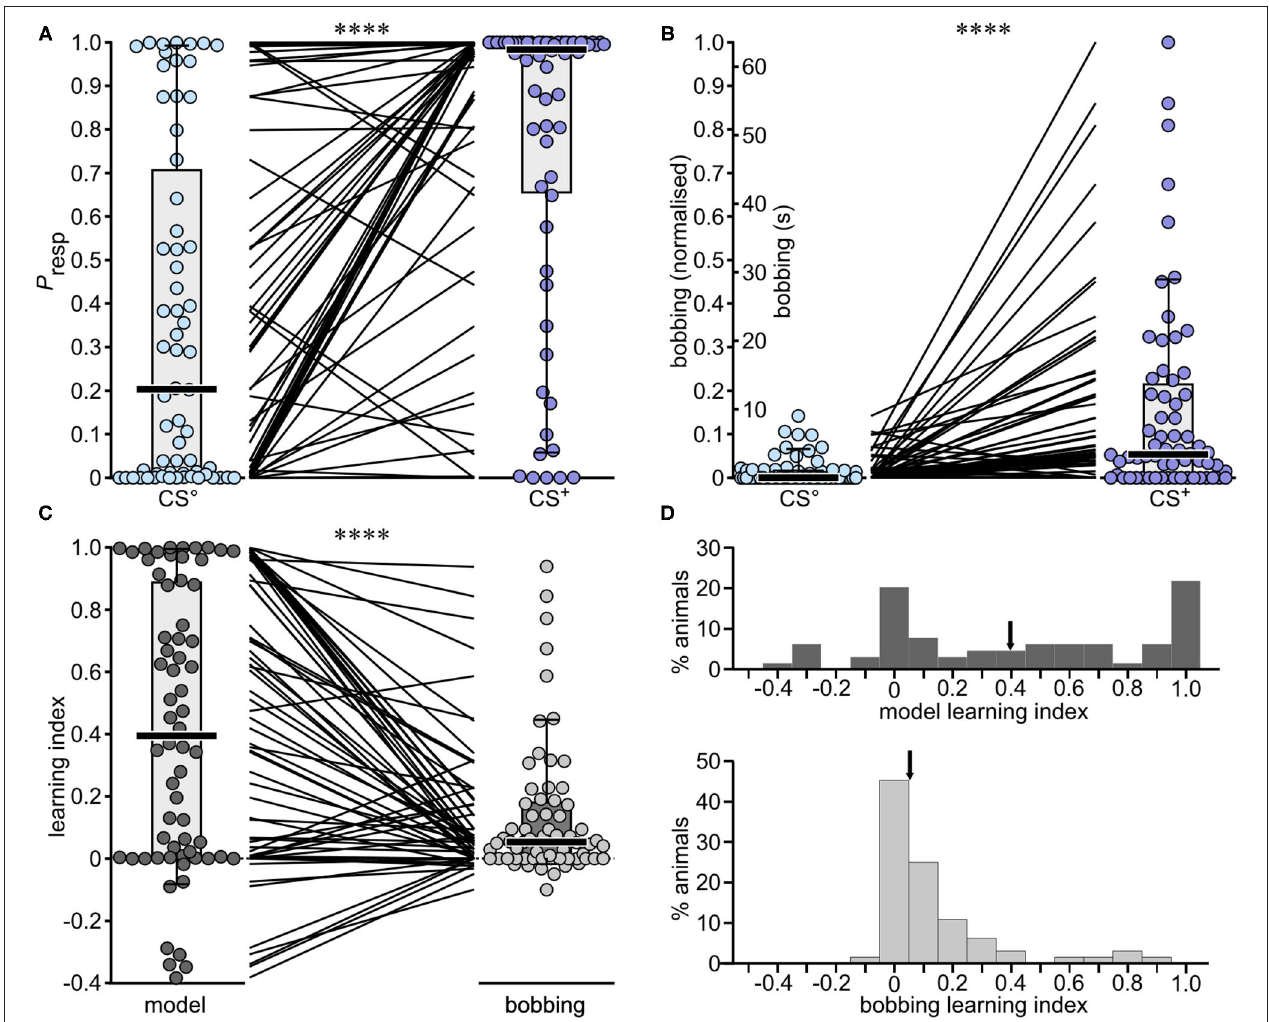
FIGURE 4 | Performances of individual crickets in the differential olfactory conditioning paradigm: A comparison of the binary regression Model-1 with bobbing . (A) Boxplots giving P resp values derived from the binary regression model for the non-rewarded and rewarded odour (CS ◦ and blue circles, respectively CS + and purple circles; bars: median; boxes: interquartile range; whiskers: 10th and 90th percentiles, N = 64). The interposing lines between plots indicate the difference in response for each individual. (B) As for (A), but for bobbing, for which the duration was normalised for the entire dataset [CS ◦ and CS + : 0 = lowest value; 1 = highest; the original data scale bobbing (s) is also depicted for comparison]. (C) Comparison of the learning indexes given by Model-1 and from normalised bobbing alone [CS + minus CS ◦ values from (A,B) respectively]. Asterisks in (A-C) indicate significant differences (Wilcoxon signed rank test; **** p < 0.0001). (D) Histograms showing the distribution of the model learning index (top) and the bobbing learning index (bottom). Arrows indicate the